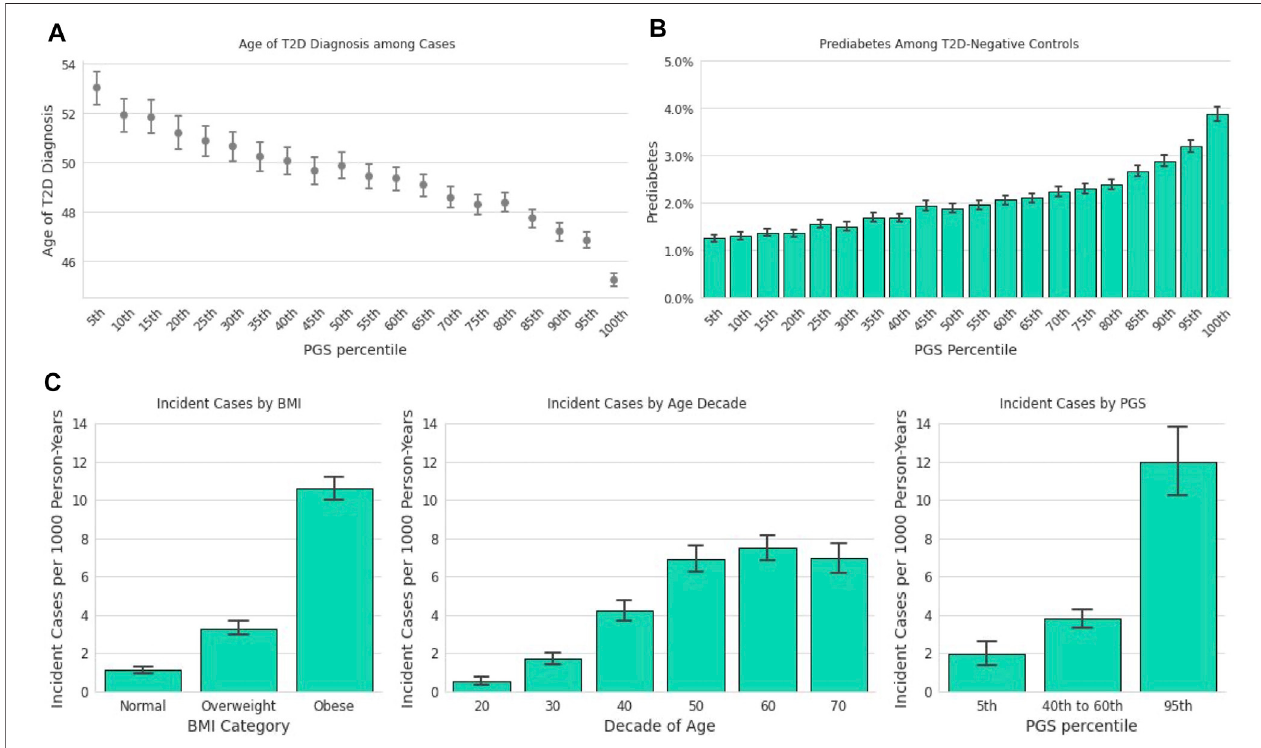
FIGURE 3 | The T2D PGS is associated with diagnosis and incidence. (A) : Mean age at T2D diagnosis (y-axis) is plotted against PGS ventiles (x-axis) among participantswhoself-reportedtheirageatT2Ddiagnosis. (B) :Prevalenceofprediabetes(y-axis) isplottedforT2D-negativeparticipantsagainstventilesofthePGS. (C) : A one-year incidence ratio was calculated among participants who were T2D negative at an initial time point and fi lled out a 1-year follow-up survey. T2D incidence (y-axis) was found to increase with increasing BMI (x-axis, left panel), with age up to the 60s (x-axis, middle panel), and PGS percentile (x-axis, right panel).